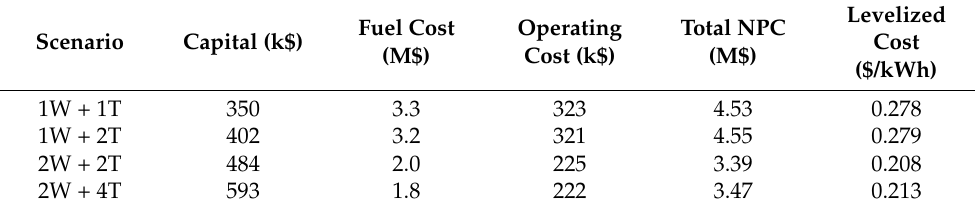
Table 8 is a summary of financial analyses for different scenarios at the Foveaux site. Table 8. Financial analysis results for different